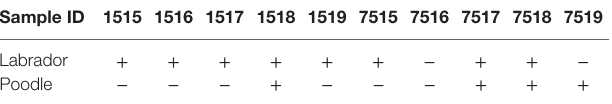
TaBle 2 | Indication ( + = correct; − = false) of dog at first contact with breath sample of healthy probands.